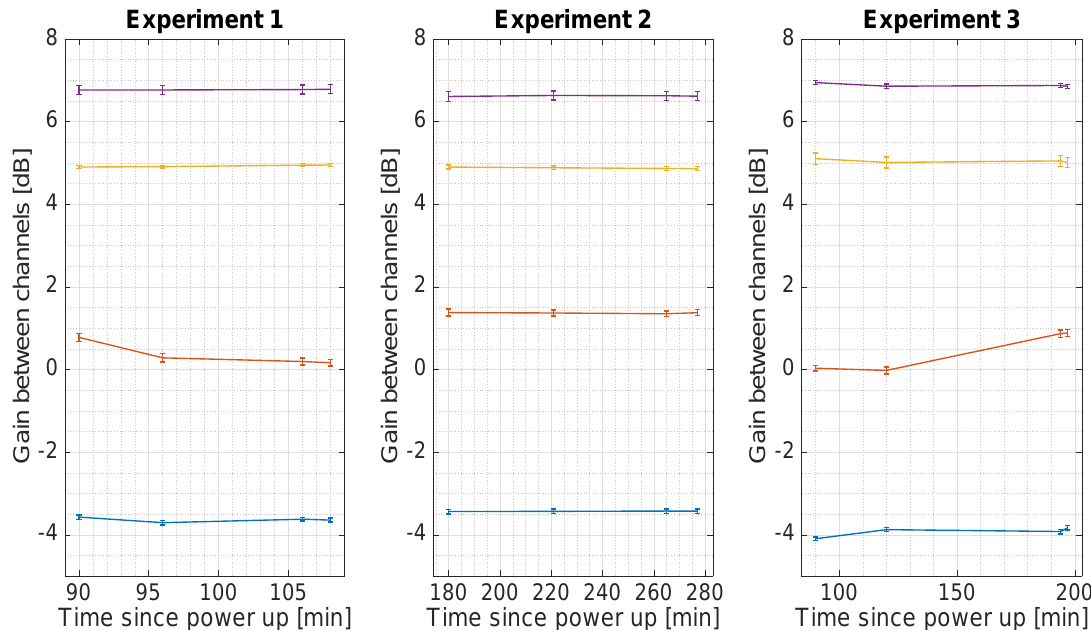
Figure 17. Estimated gain between the direct and reflected RF channels for the four different USRPs during three sets of experiments. The lines show the drift between the estimations, and the markers are error bars. The mean and the standard deviation have been computed as geometric mean and geometric standard